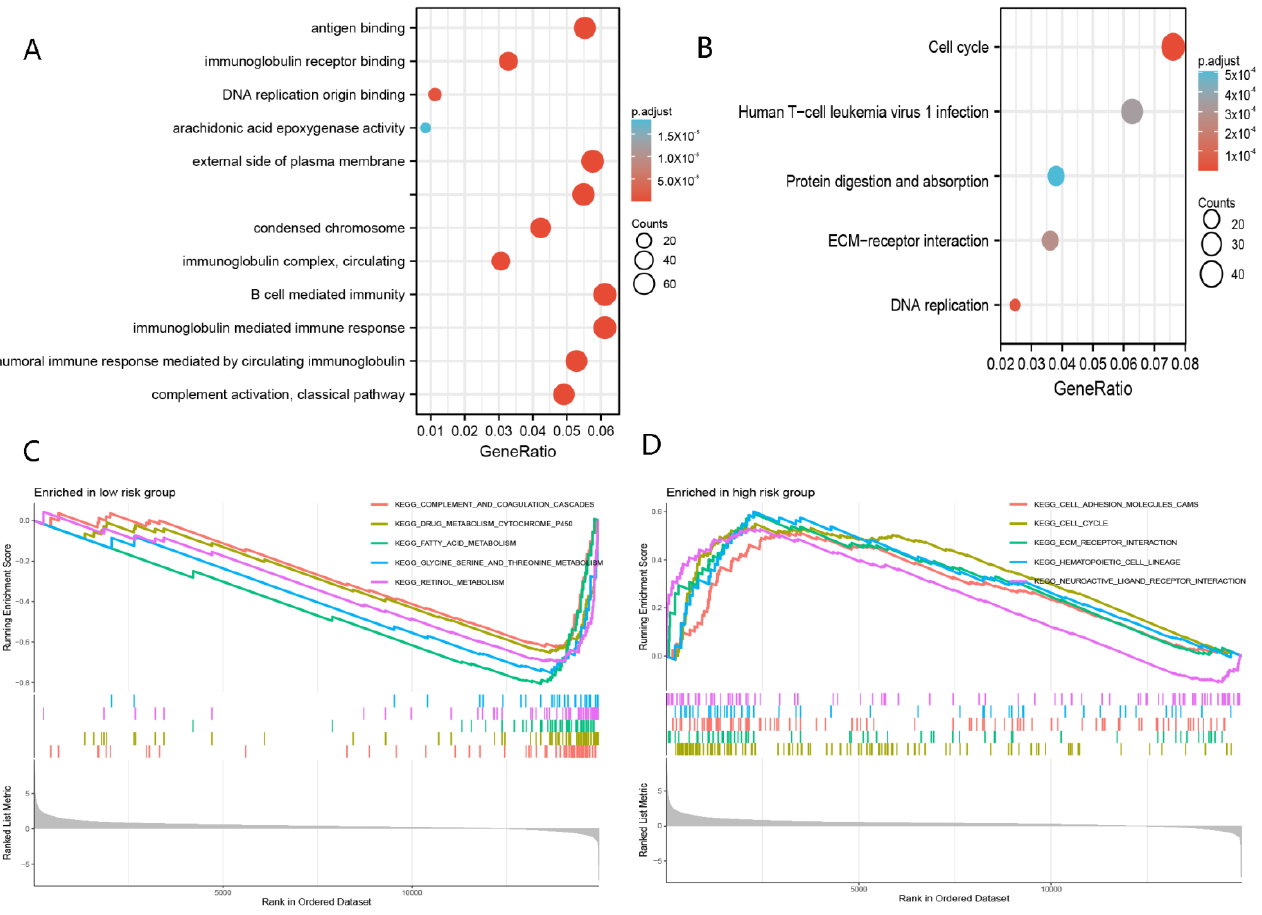
Figure 9. Molecular function analyses. ( A ) Go analysis of DEGs. ( B ) KEGG analysis of DEGs. ( C ) GSEA analysis in the high-risk group. ( D ) GSEA analysis in the low-risk group.